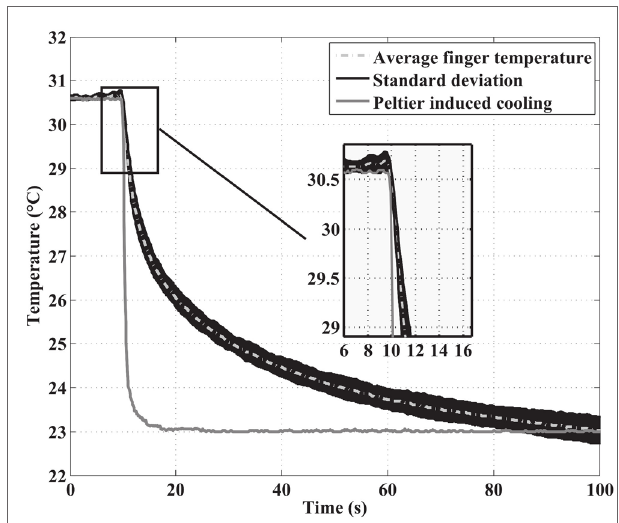
FigUre 4 | comparison between copper-induced and display- induced cooling of the finger . Average and SD of the finger temperature drop when touching copper as well as maximum cooling rate profile of the thermal display are shown. Note that the display can guarantee a cooling rate higher than the one necessary to render the common material with highest cooling rate, i.e.,